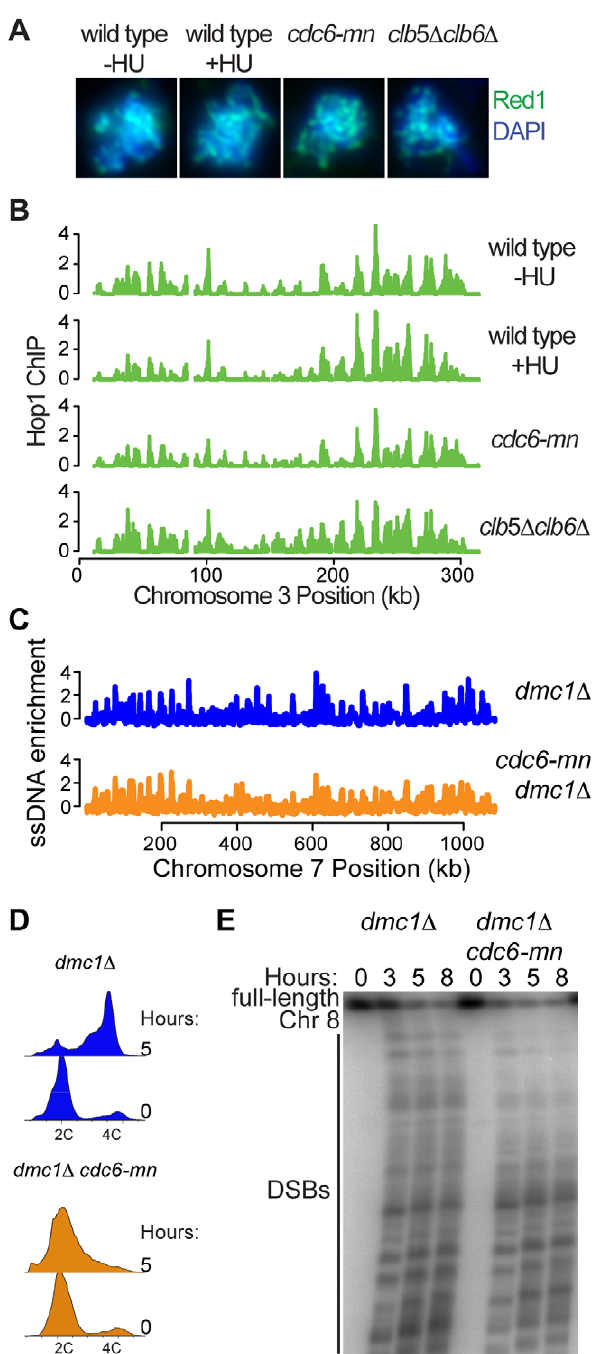
Figure 6. DNA replication is not required for axis association or DSB formation. (A) Indirect immunofluorescence for Red1 (green) and DAPI staining for total DNA (blue) on spread nuclei from cells at 3 hours after inoculation into SPO for wild-type cells (H119) with and without HU, cdc6-mn cells (H154) and clb5 D clb6 D cells (H2017). (B) Hop1 localization analysis was performed for wild-type cells with (H4471) and without HU (H119, [67]), cdc6-mn cells (H154) and clb5 D clb6 D cells (H2017). The enrichment of Hop1 over input DNA is plotted for chromosome III. (C) ssDNA enrichment in dmc1 D cells (H118, [67]), and dmc1 D cdc6-mn cells (H1584) was plotted with respect to position on chromosome VII. (D) FACS analysis was performed for dmc1 D (H118) and dmc1 D cdc6-mn cells (H1584). (E) CHEF gel analysis of chromosome VIII during a meiotic time course using dmc1 D (H118) and dmc1 D cdc6-mn cells (H4534).